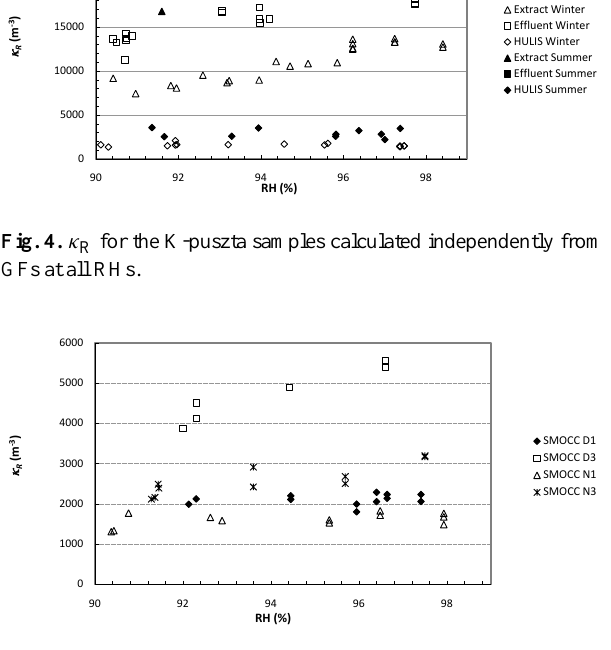
Fig. 5. κ R for the SMOCC HULIS samples calculated indepen- dently from GFs at different RHs.